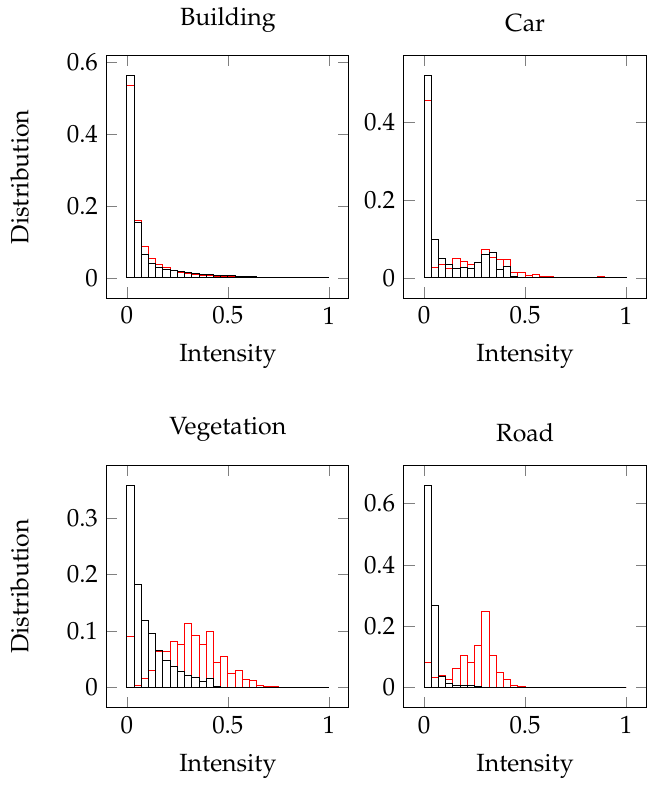
Figure 8. Intensity values for different classes and sensors (black for ParisLille, red for SemanticKITTI). The distribution for the classes building and car are comparable. Vegetation and road on the other hand highly